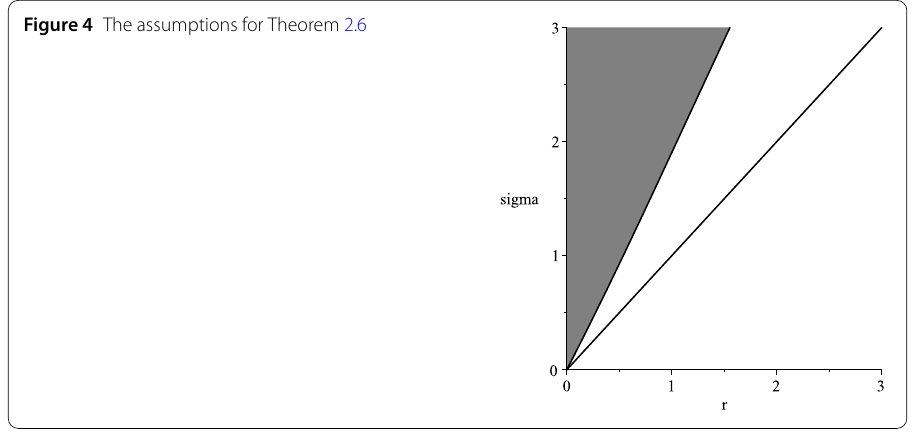
Figure 4 The assumptions for Theorem